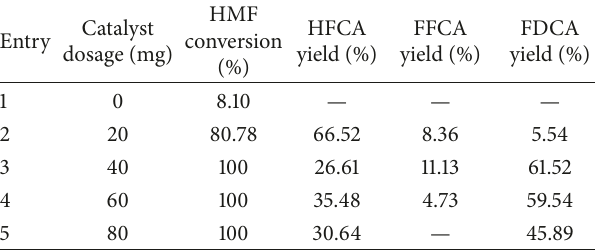
Table 1: The effect of catalyst dosage on the HMF oxidation. a